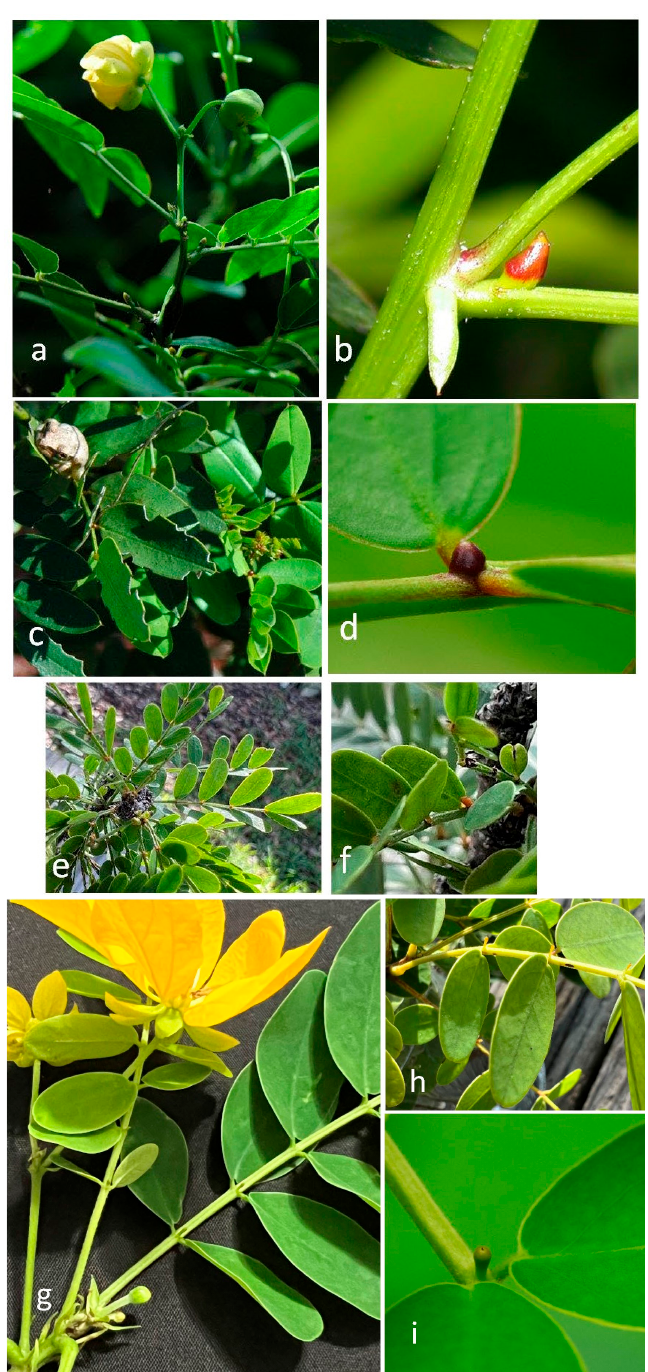
Figure 4. Senna species and nectaries—( a ) Senna ligustrina habit, ( b ) closeup of S. ligustrina nectary at base of leaf; ( c ) S. mexicana var. chapmanii habit, ( d ) closeup of S. mexicana nectary between lowest pair of leaflets; ( e ) S. polyphylla habit, ( f ) closeup of S. polyphylla nectary between lowest pair of leaflets. ( g ) S. surattensis habit, leaf with two foliar nectaries between basal leaflet pairs; ( h ) S. surattensis leaf with three nectaries, exuding nectar; ( i ) close ‐ up of single nectary of S. surattensis between a pair of leaflets.